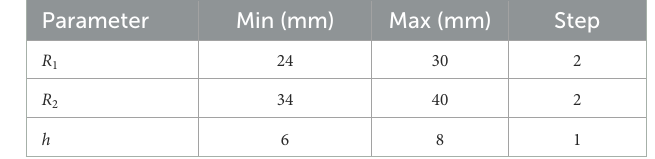
TABLE 3 Sample number and fitting mean square errors.